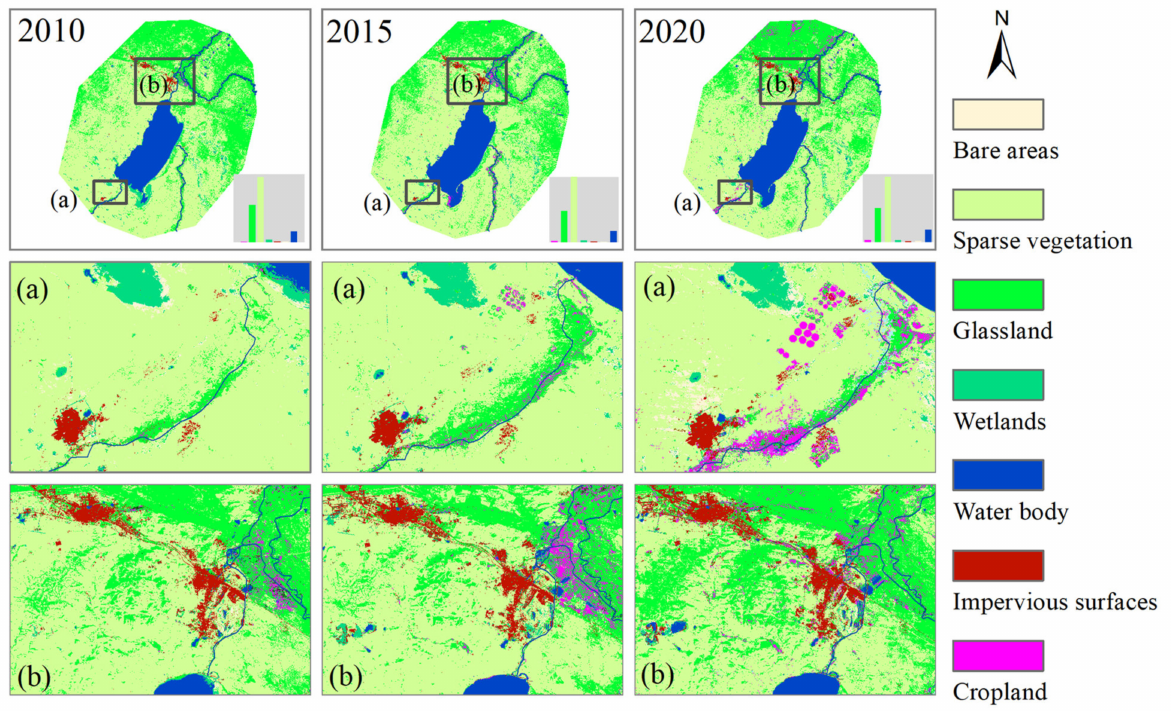
Figure 10. Land use/land cover images of Hulun Lake from 2010 to 2020. ( a ) Land use/land cover in the southwest of the study area; ( b ) Land use/land cover in the northeast of the study